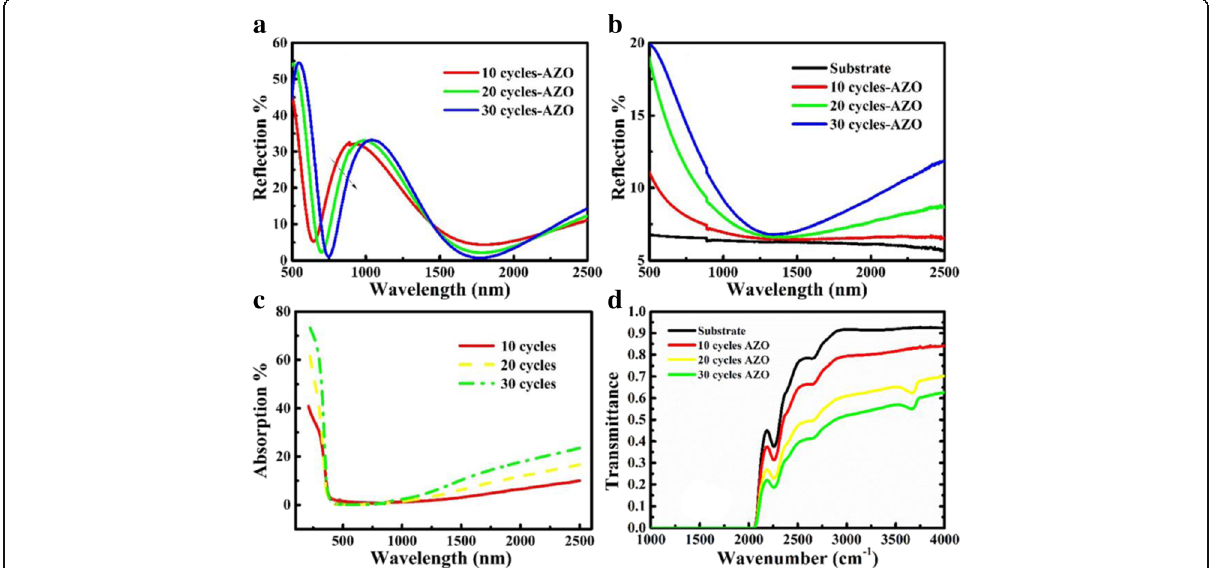
Fig. 5 a Reflection of AZO films on Si substrate; b Reflection, c absorption, and d transmittance of AZO films on SiO 2 substrate